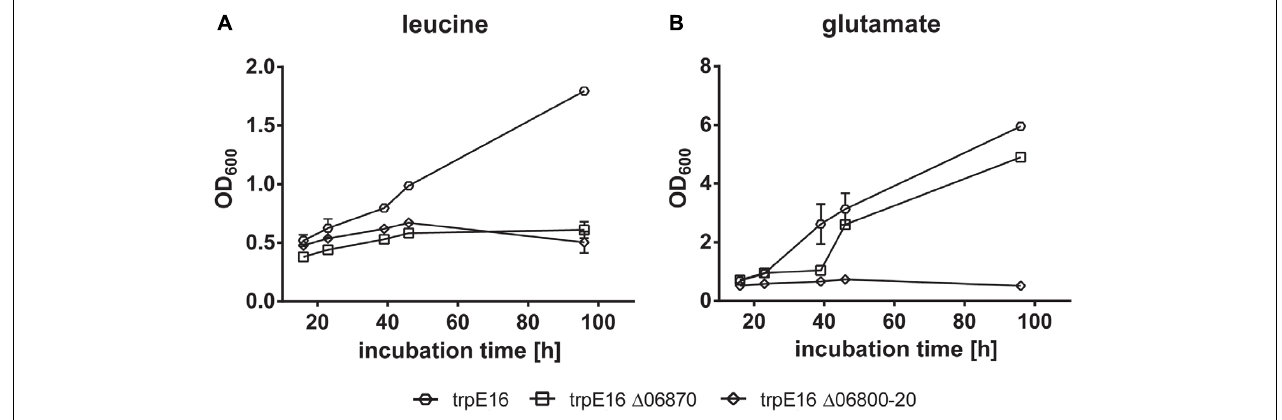
FIGURE 8 | Growth curves of BCKD (Mlut_06800-20) and isovaleryl-CoA dehydrogenase (Mlut_06870) deletion mutants in glucose minimal medium supplemented with leucine (A) or glutamate (B) as the only nitrogen source. Each curve represents data from two biological replicates, error bars represent standard